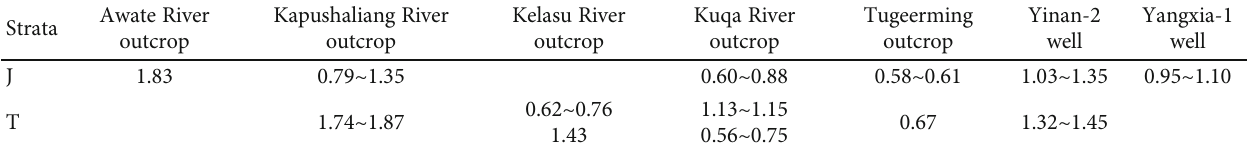
Table 2: The vitrinite re fl ectance (Ro, %) of the source rock in outcrops and wells in the Kuqa Basin.